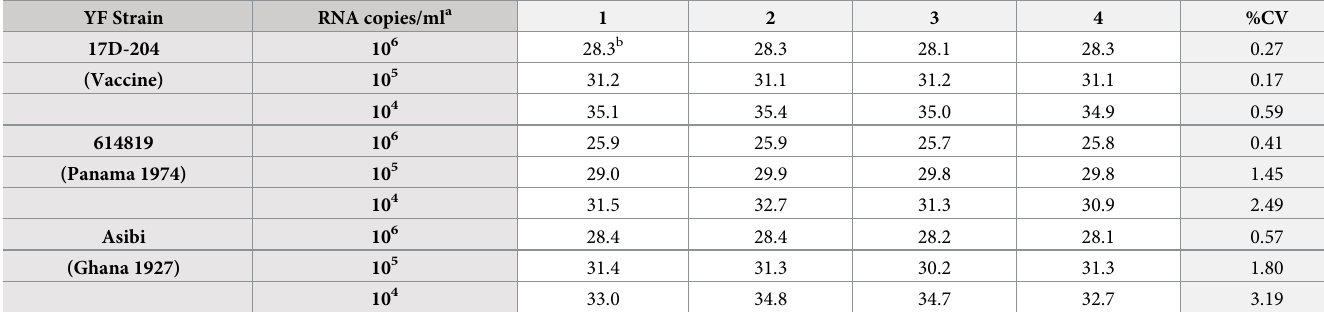
YF, yellow fever; RNA, ribonucleic acid; %CV, coefficient of variation. a Approximate RNA copies/ml b Cycle threshold (Ct) value